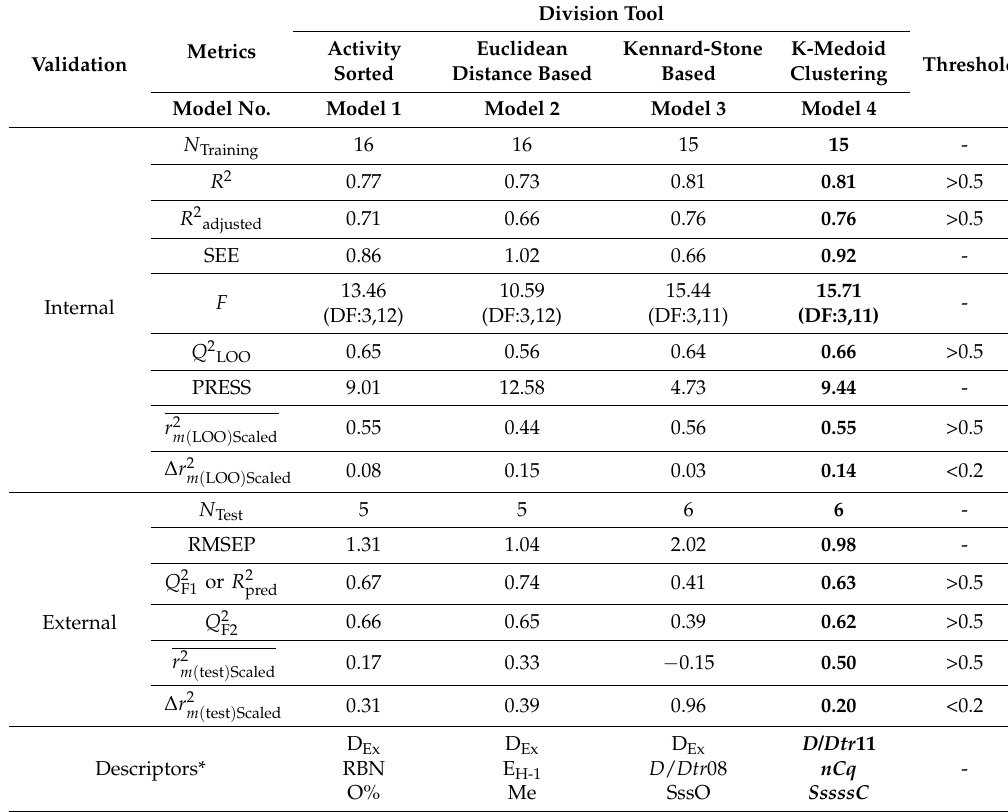
Table 2. Statistical quality of QSPR models developed based on different division